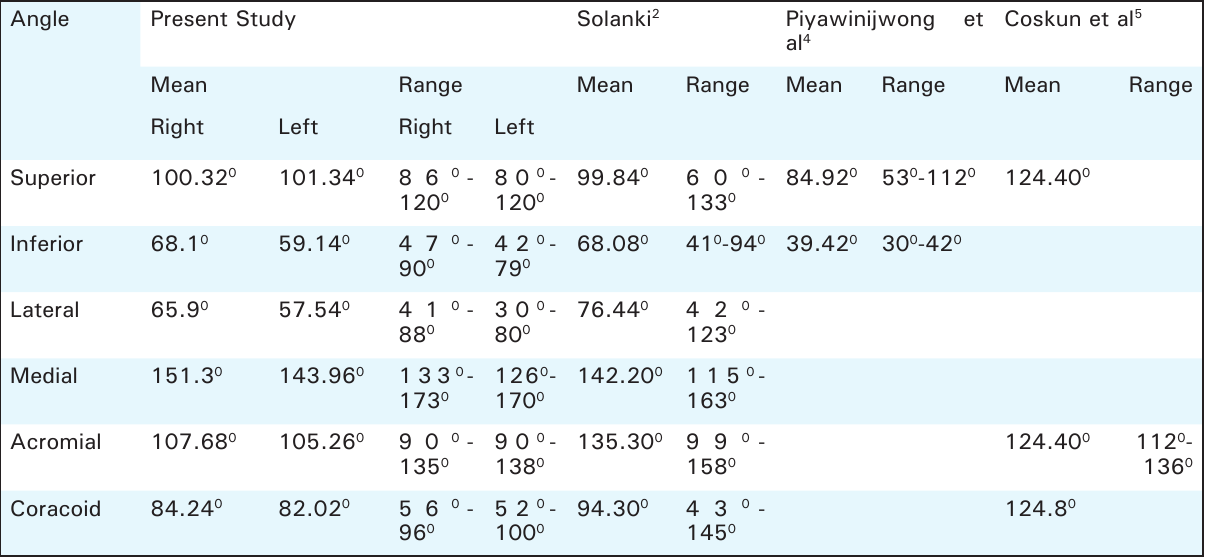
Table 1. Showing comparison of different angles of scapula with earlier studies. Angle Present Study Mean Range Mean Range Mean Range Mean Range Right Left Right Left Superior 100.32